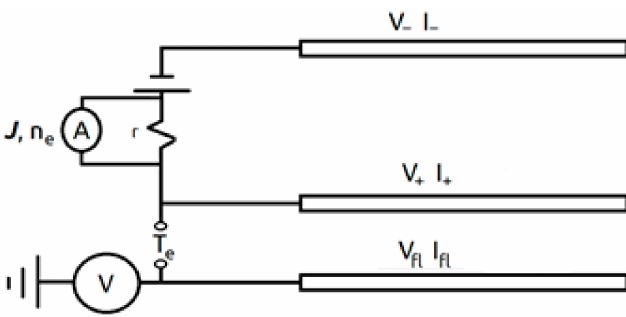
Figure 8. The triple Langmuir probe electrical